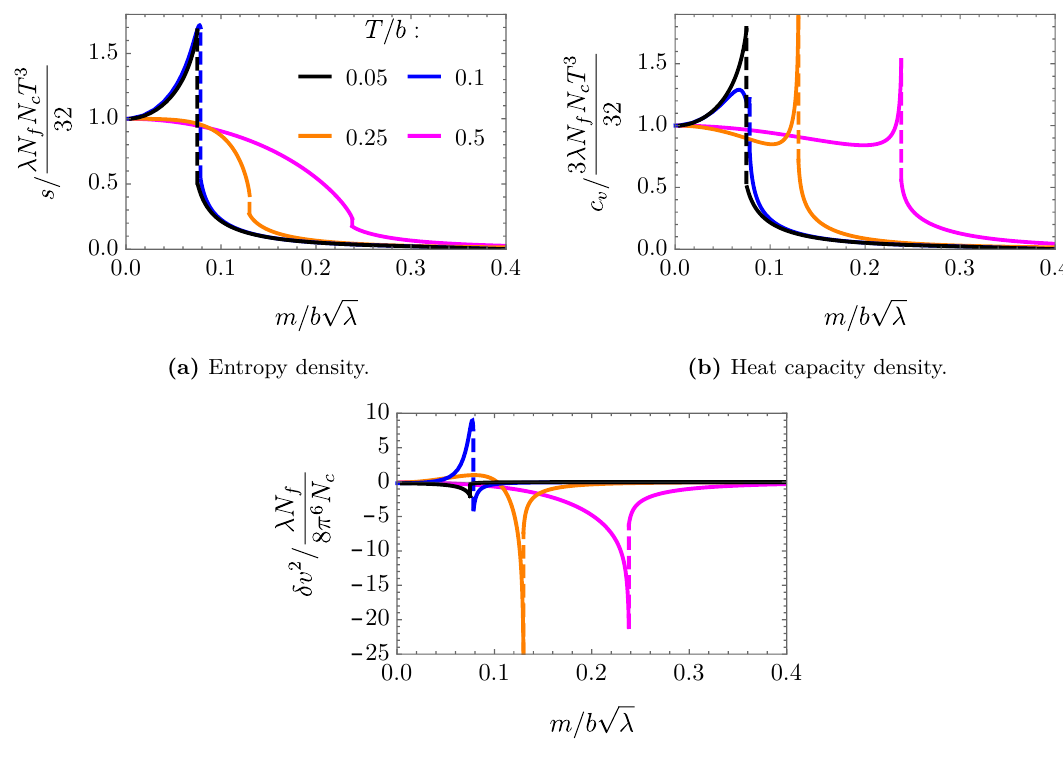
Figure 5. (a) Our numerical results for the entropy density, s , normalised by its m = 0 value in √ λ ) , for T/b = 0 . 05 (solid black), 0 . 1 (solid blue), eq. (3.21), λN f N c T 3 / 32 , as a function of m/ ( b 0 . 25 (solid orange), and 0 . 5 (solid pink). (b) Our numerical results for the heat capacity density, √ c V , normalised by its m = 0 value in eq. (3.21), 3 λN f N c T 3 / 32 , as a function of m/ ( b λ ) , for the same values of T/b as in (a). (c) Our numerical results for the O ( N f /N c ) correction to the sound √ λ ) , for the same values of T/b as in (a) and speed squared, δv 2 in eq. (3.3), as a function of m/ ( b (b). In each case the dashed vertical lines denote a first-order phase